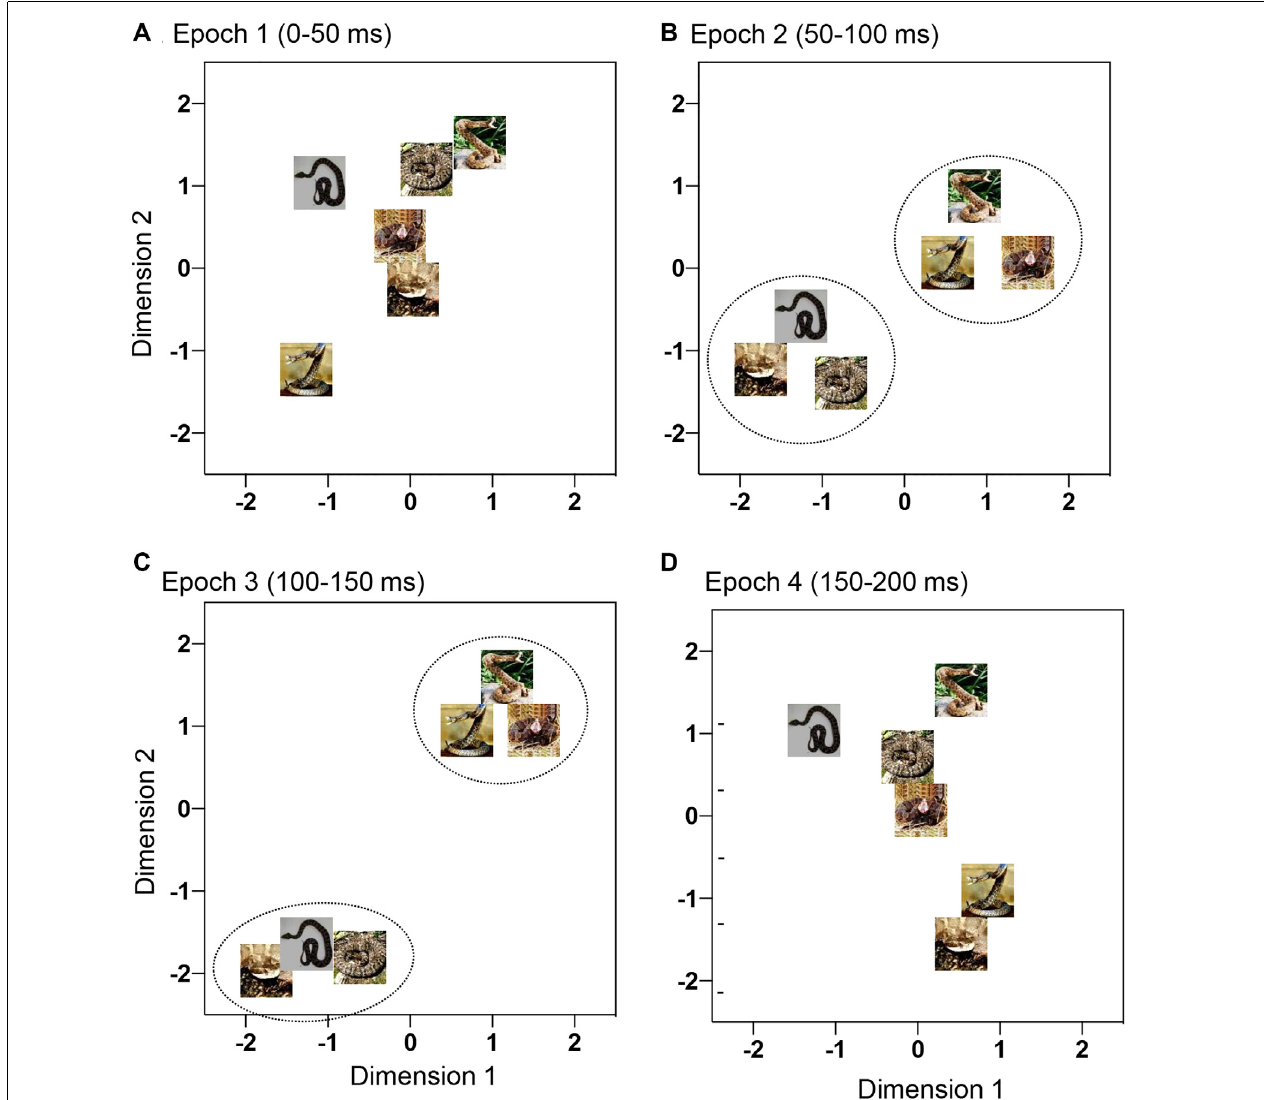
FIGURE 4 | Distributions of the six snake photos in a 2-D space derived from multidimensional scaling (MDS) analysis of response magnitudes of the 95 mPFC neurons to these photos. (A–D) Response magnitudes were analyzed by MDS epoch 1 (A) , epoch 2 (B) , epoch 3 (C) , and epoch 4 (D) . In epochs 2 and 3 (B,C) , the snakes with striking postures were separated from the snakes with non-striking postures ( p <